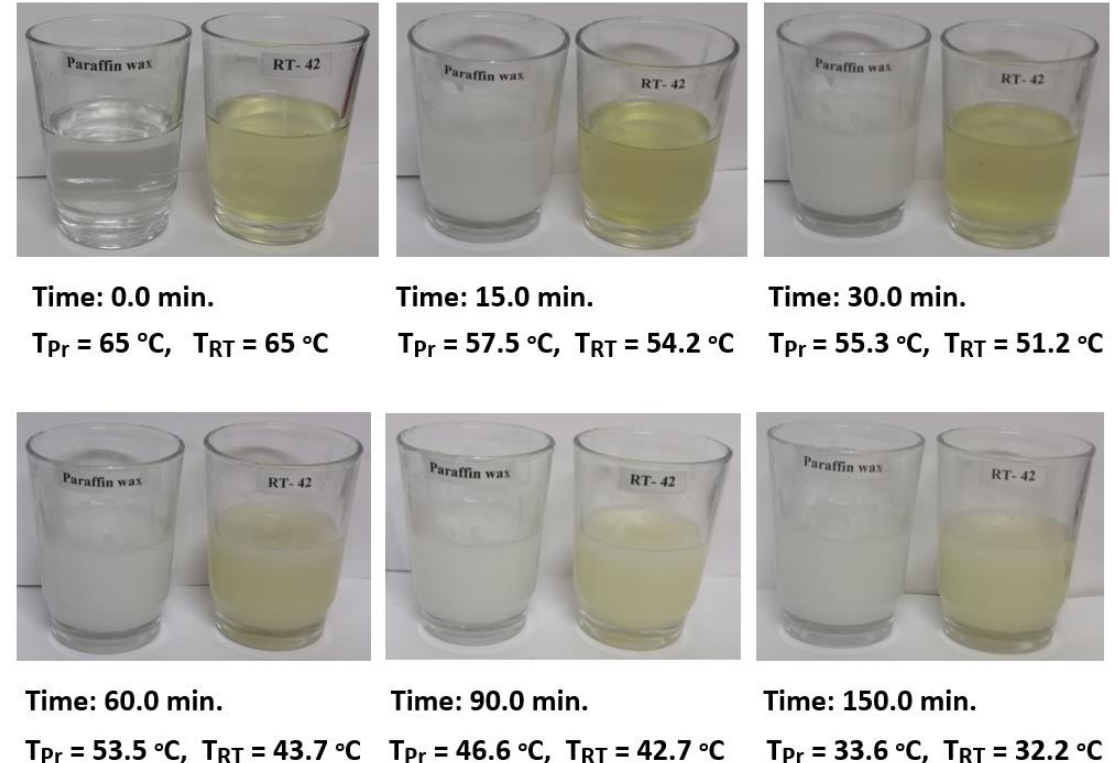
Figure 4. Solidification steps for 50 g of PCM1 (T pr ) and PCM2 (T RT ) heated to 65 °C and cooled at ambient air temperature (T am = 30.6 °C).